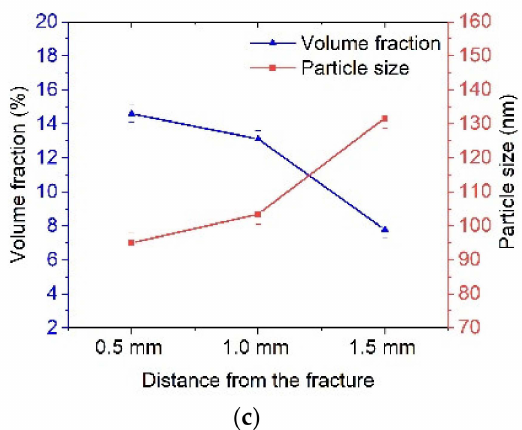
Figure 10. Changes in the structural parameters of the steel after fatigue tests depending on the dis- tance from the fracture zone: ( a ) tempered sample, ( b ) CR sample, and ( c ) CR + requenching sample.